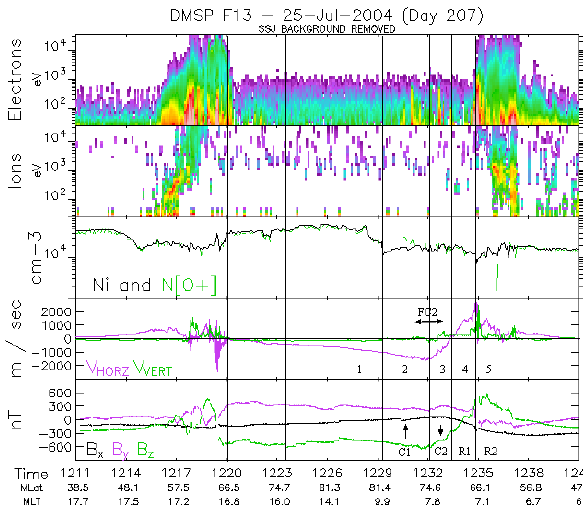
Fig. 11. DMSP F13 data obtained during the interval 12:11– 12:41UT on 25 July 2004. Panels from top to bottom shows (i) electron precipitation spectrogram (particle flux versus energy and time), (ii) ion precipitation flux, (iii) ion densities, (iv) cross track (violet trace) and vertical ion drifts, and (v) magnetic deflec- tion components B x , B y , and B z . Same format as in Fig.